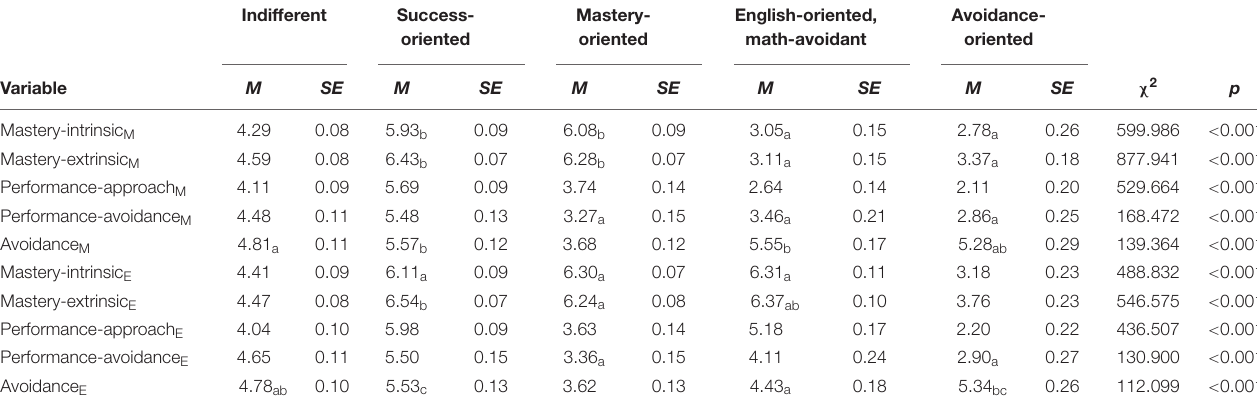
TABLE 4 | Mean differences in achievement goal orientations between the latent goal orientation profiles based on the Bolck–Croon–Hagenaars (BCH) method.